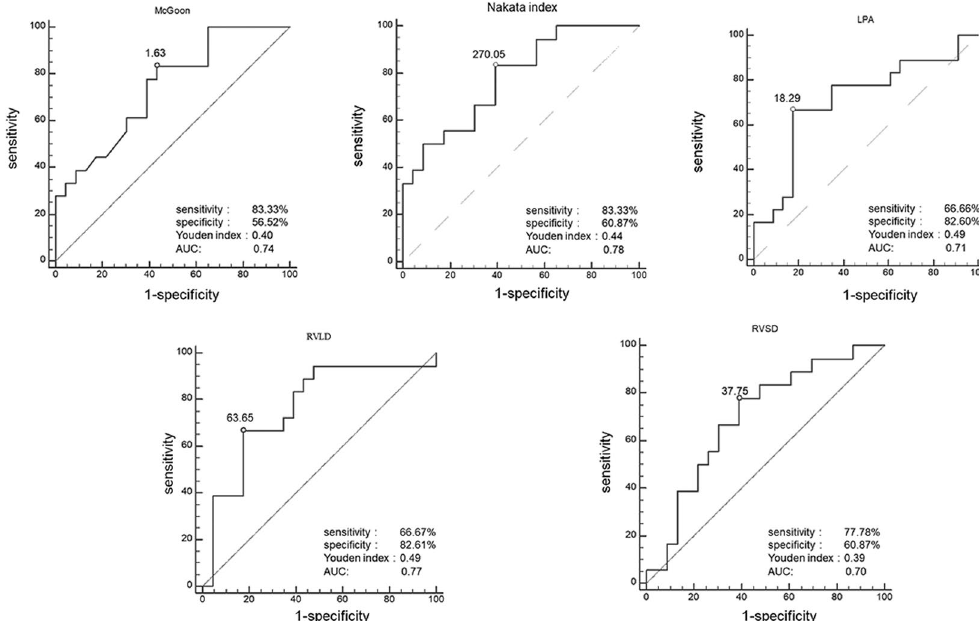
Figure 1. The ROC analysis to predict the relationship between the pulmonary regurgitation and measurements. In ROC analysis, the sensitivity and specificity of McGoon ratio (McGoon ratio > 1.63) with DSCT for predicting pulmonary regurgitation in TOF patients were 83.3% and 56.5%, the values for Nakata index (Nakata index > 270.05) were 83.3% and 60.8% and the values for LPA diameter (LPA diameter > 18.29) were 66.7% and 82.6%. The RVLD value < 63.65 and RCSD value < 37.75 as moderate sensitivity cutoff values (RVLD, sensitivity 66.7%, specificity 82.6%; RVSD, sensitivity 77.8%, specificity